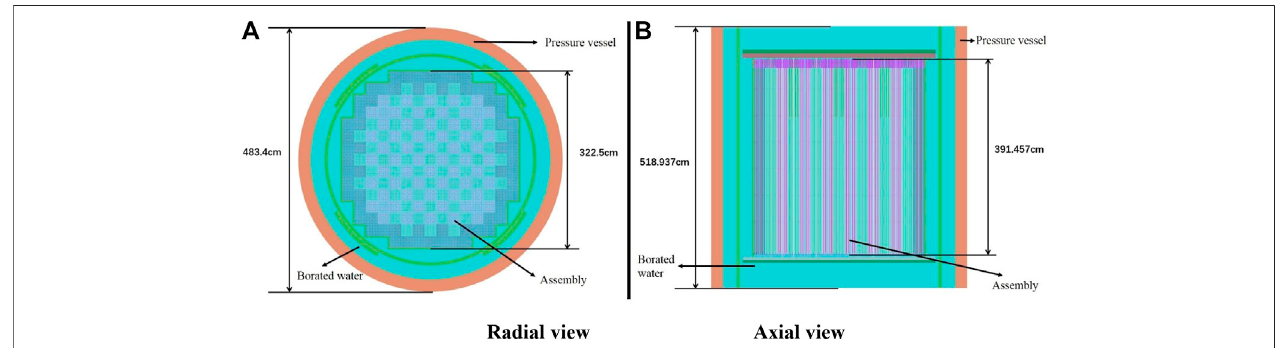
FIGURE 6 | The geometry of the full VERA core. (A) Radial view (B) Axial view.